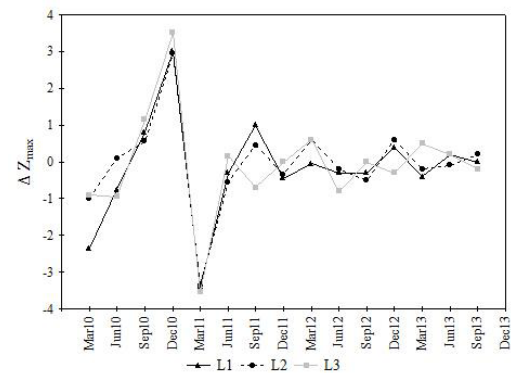
Figure 3. Temporal variation of the water level (ΔZ of lakes in the upper Paraná River floodplain from March 2010 to December 2013. For each lake, the variation was considered as the difference between the water level registered in a sampling and the previous sampling. Table 1. Mean values and coefficient of variation (% - CV) of the limnological variables in the studied environments.